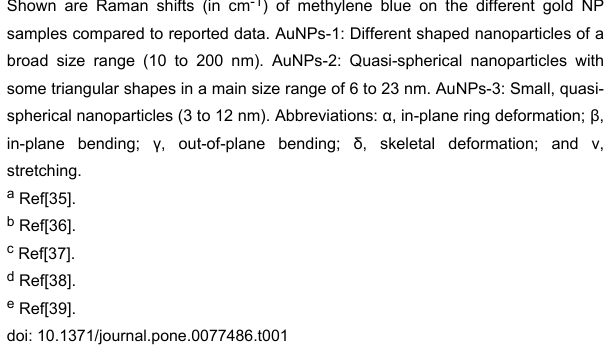
Figure S1. Statistical analysis. ANOVA of gold nanoparticles synthesized under different pH values and at different time points. A: Average sizes of nanoparticles at different time points with respect to different pH values. B: Tukey’s HSD post hoc test analysis with average nanoparticle size information. Vertical bars denote 0.95 confidence intervals. Significant differences are marked in red. (TIF) Figure S2. NP Stability. Size distribution histograms of gold NPs synthesized at 60°C and pH 3 (A), pH 5.5 (B), and pH 10 (C) after more than 10 months storage at room temperature.